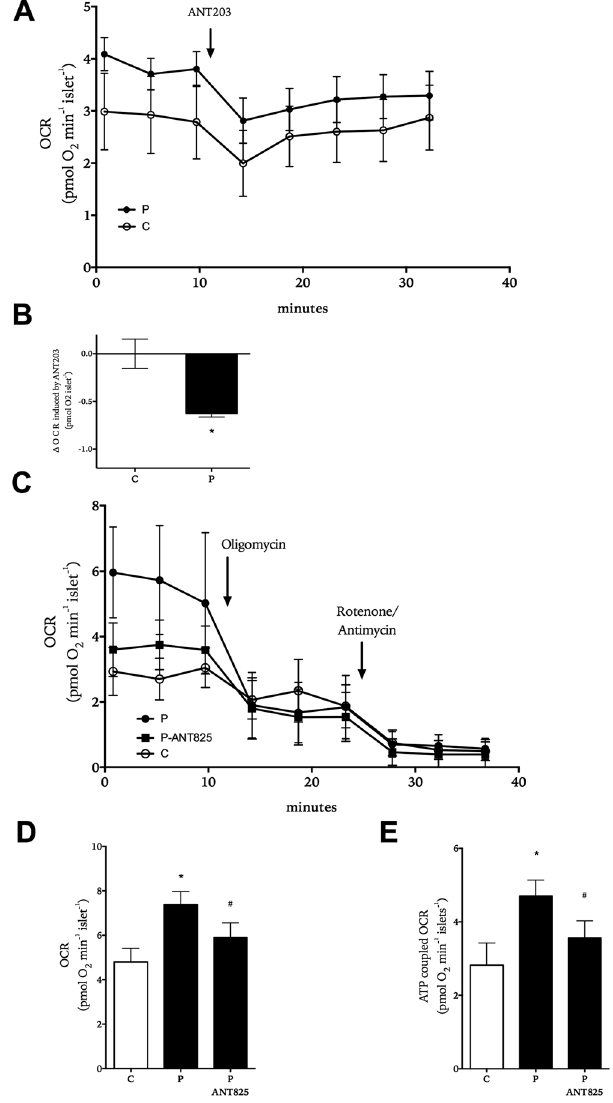
Figure 4. Role of FFAR1 in the effect of palmitate on human islet respiration. OCR recordings from human islets exposed to 5.6 mM glucose (white symbols) and 0.5 mM palmitate (black symbols) and sequential addition of ANT203 (panel A). Difference in OCR 20 minutes prior and post addition of ANT203 (panel B). OCR recordings from human islets exposed for 2 hours to 5.6 mM glucose (white symbols), 0.5 mM palmitate (black circles, black bars) or palmitate with ANT825 (black triangles, black bars) and the sequential addition of oligomycin and rotenone/antimycin (panel C). Mitochondrial respiration (panel D) and ATP-coupled respiration (panel E) are shown. Results show mean ± SD in ( panels A − C ) (N = 10) and mean ± SEM in (panels D and E) (n = 5–7 donor experiments). * P < 0.05 vs. control and # p < 0.05 vs.